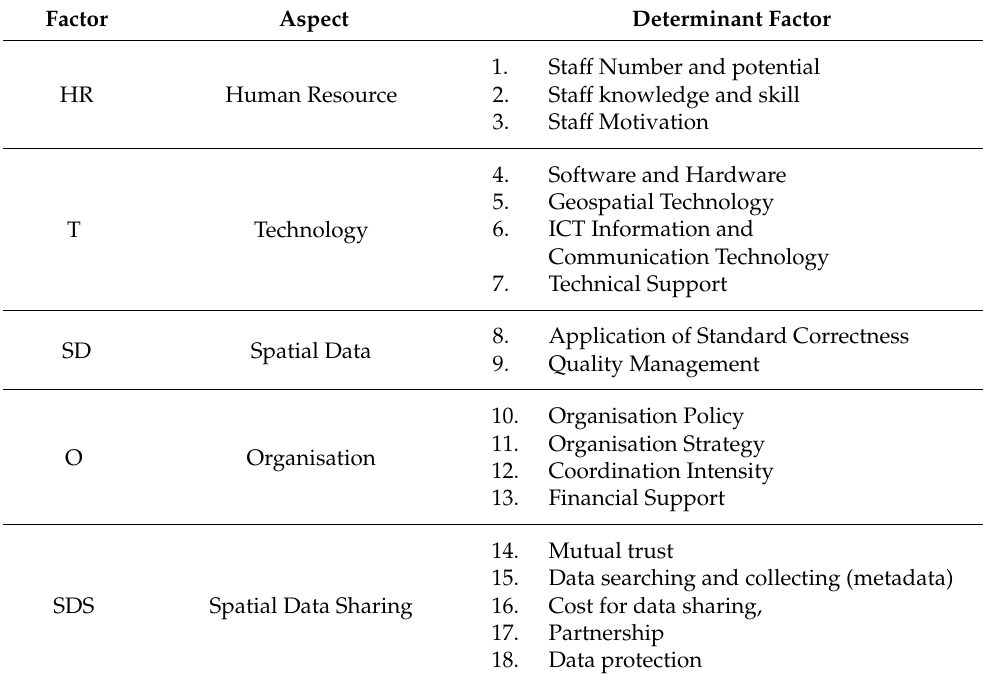
Table 5. Spatial data sharing and factors at the local SDI